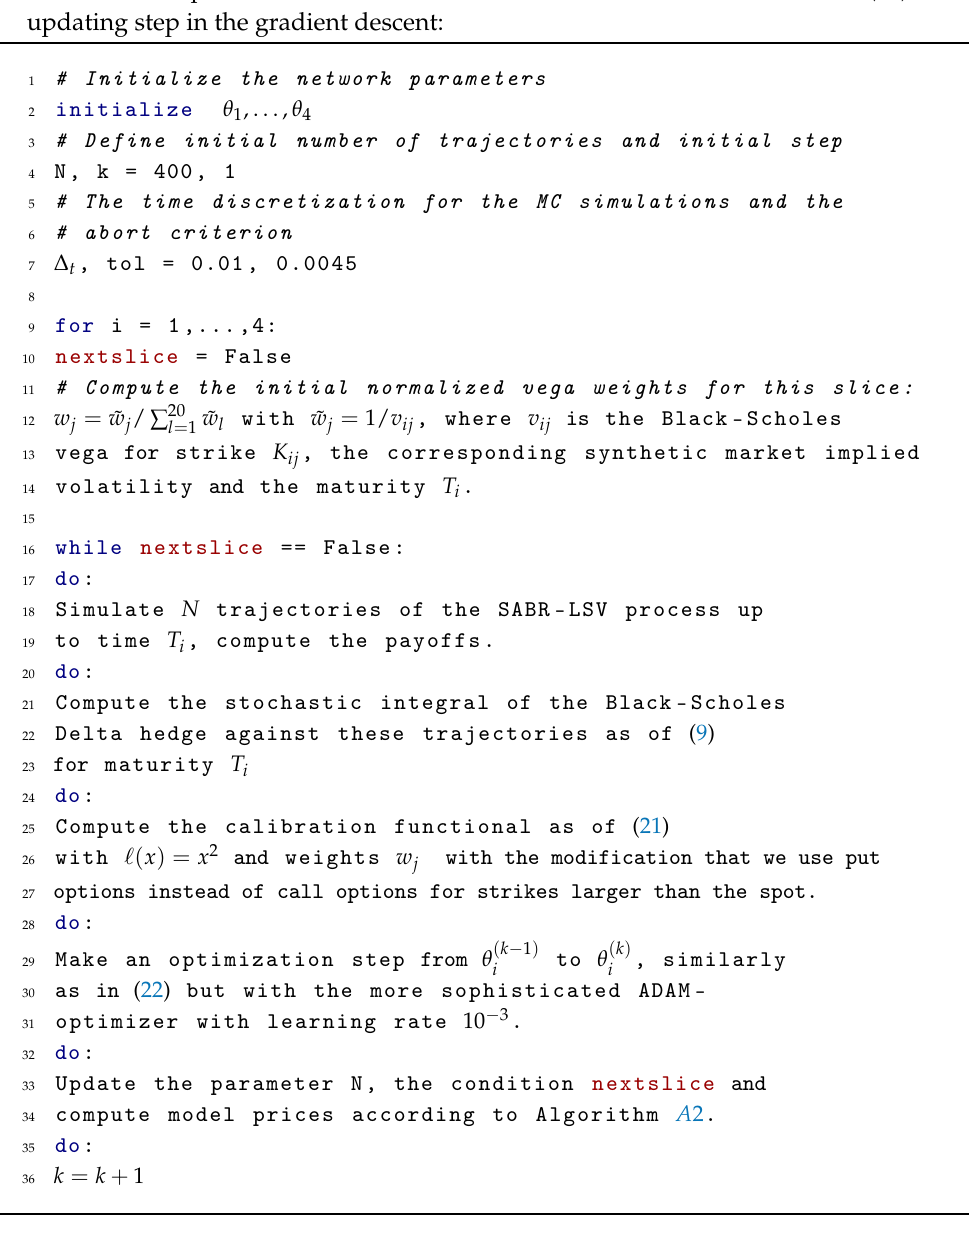
Algorithm A1: In the subsequent pseudo code, the index i stands for the maturities, N for the number of samples used in the variance reduced Monte Carlo estimator as of (21) and k for